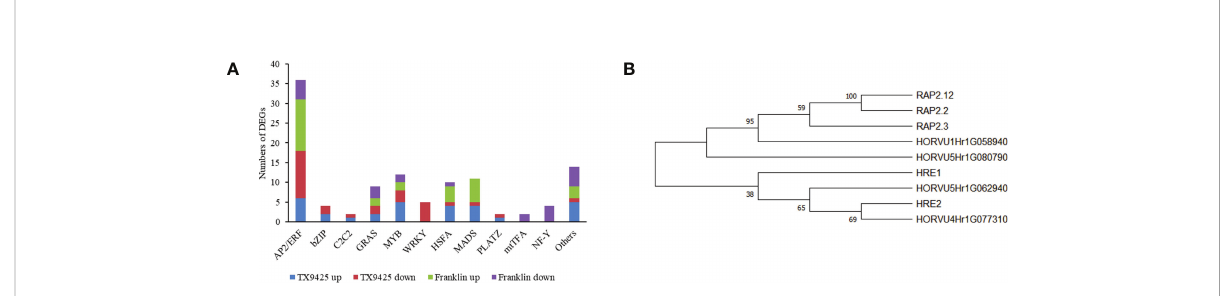
FIGURE 4 Differentially expressed genes (DEGs) associated with the transcription factor (TF) activity in response to barley waterlogging tolerance. (A) Twelve different TF families representing highest number of up- and down-regulated DEGs. (B) Phylogenetic tree of barley and Arabidopsis ERF VII proteins. Full-length protein sequences were analyzed using Neighbor-joining method in MEGA software. Numbers above branches indicate the bootstrapped value from 1000